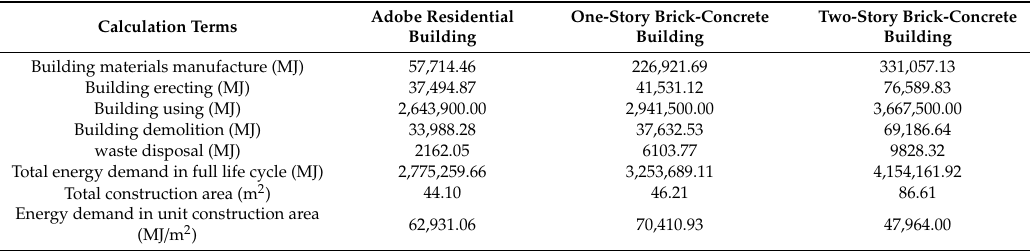
Table 22. Energy demand in each process of full life cycle for the three residential buildings (MJ).